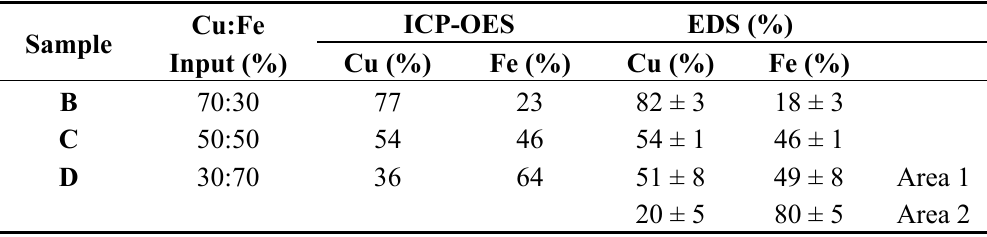
Table 1. Inductively coupled plasma–optical emission spectroscopy (ICP-OES) and energy dispersive X-ray spectroscopy (EDS) determined atomic compositions for nanoparticle